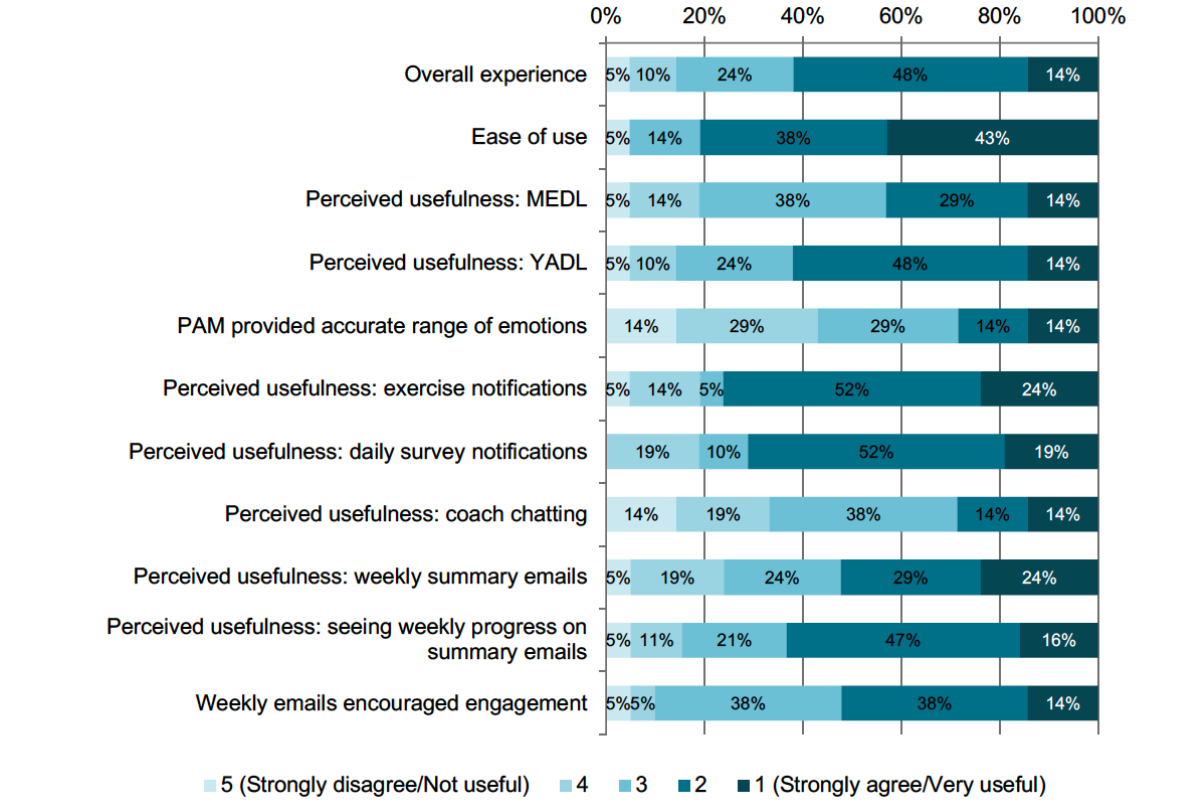
Figure 7. Feedback survey results. Surveys were scored on a 5-point Likert scale with response options ranging from “strongly disagree/not useful” (5 points) to “strongly agree/very useful” (1 point). Percentages may not sum to 100% because of rounding. YADL: Your Activities of Daily Living; MEDL: Medications of Daily Living; PAM: Photographic Affect